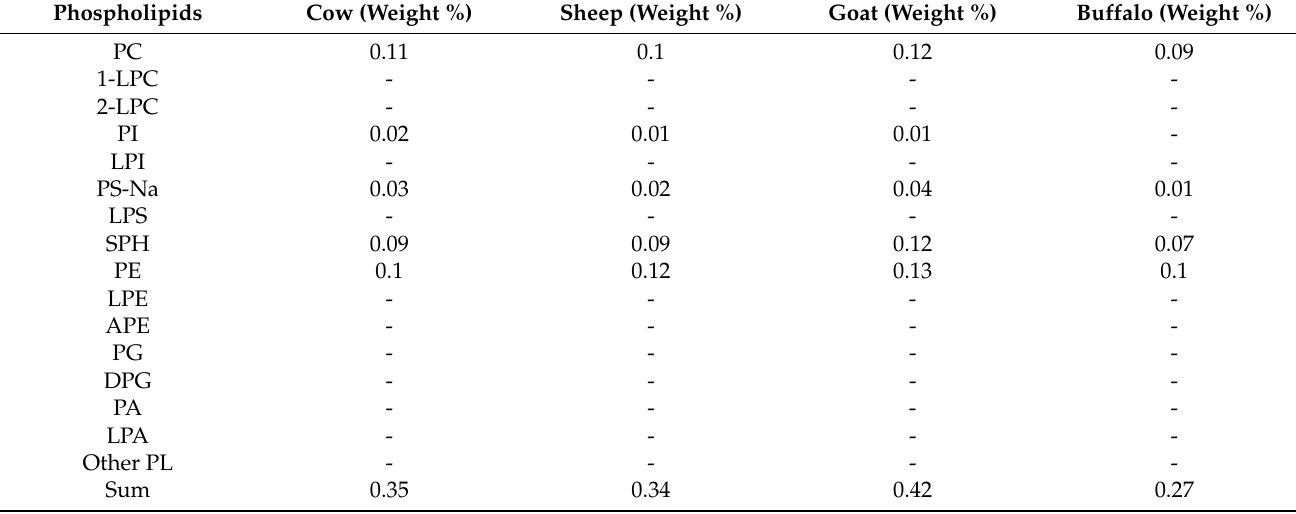
Table 7. Phospholipids content in cream samples from cow, buffalo, goat and sheep samples. Values are expressed